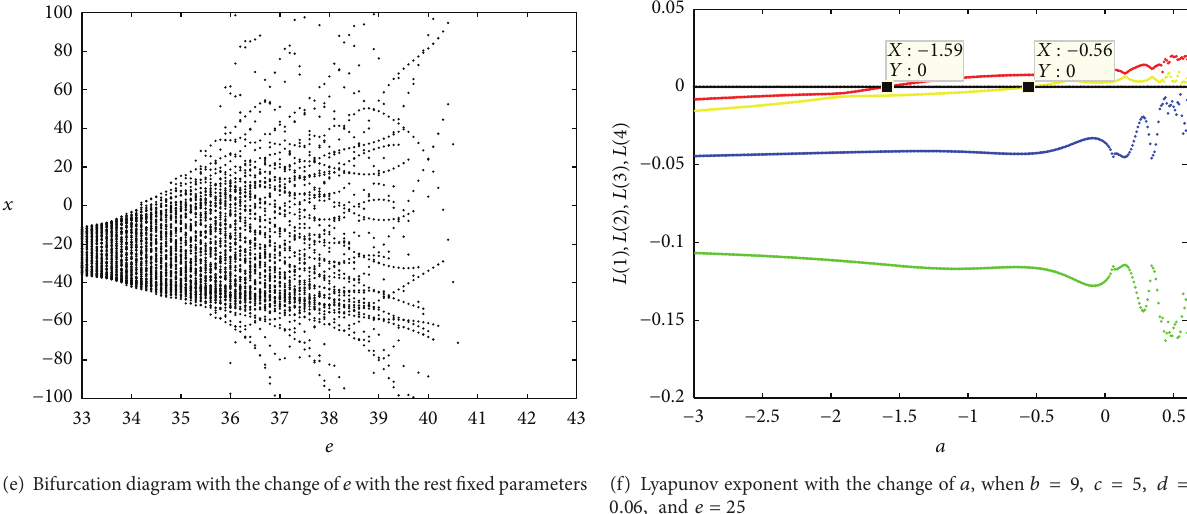
(c) Bifurcation diagram with the change of 𝑐 with the rest fixed parameters